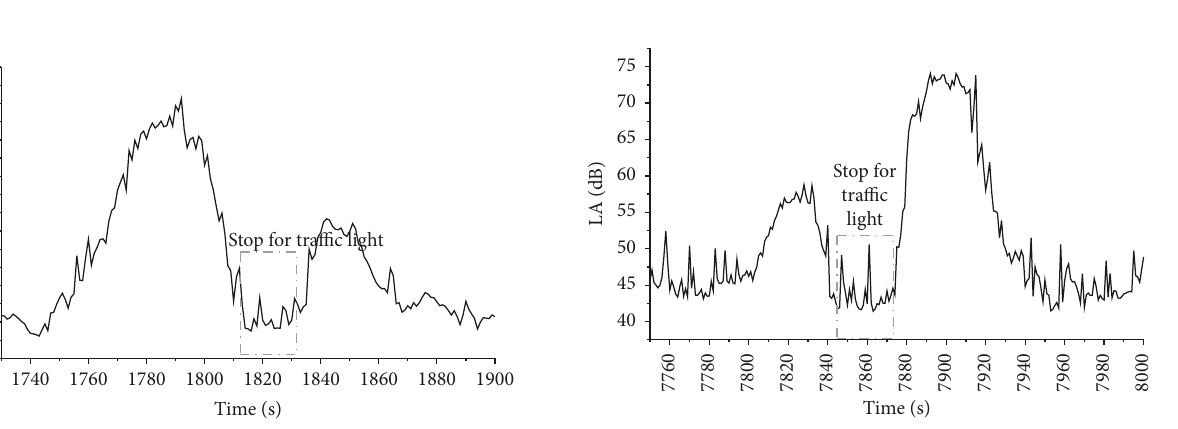
Figure 6: Example of time history for the whole measurement in rush hours (MS3).